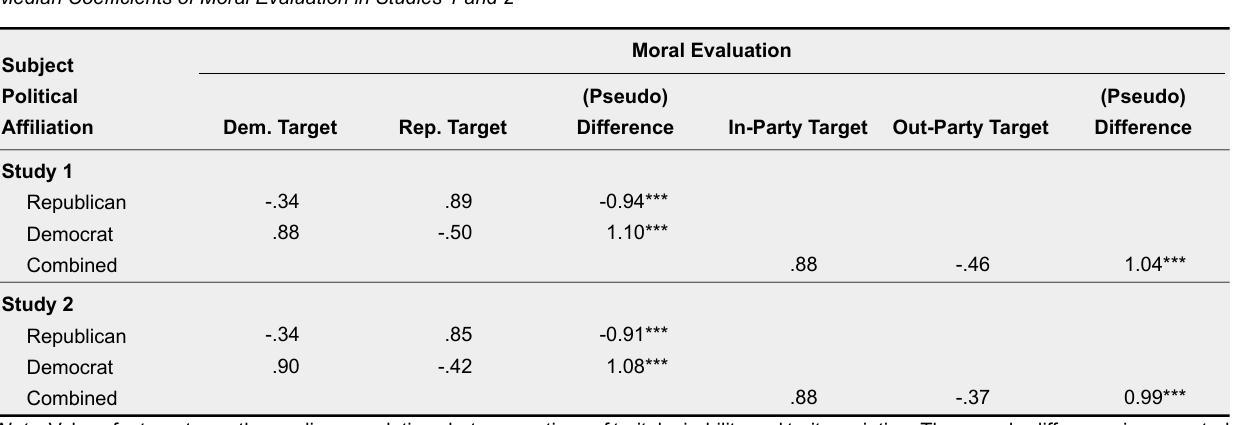
Median Coefficients of Moral Evaluation in Studies 1 and